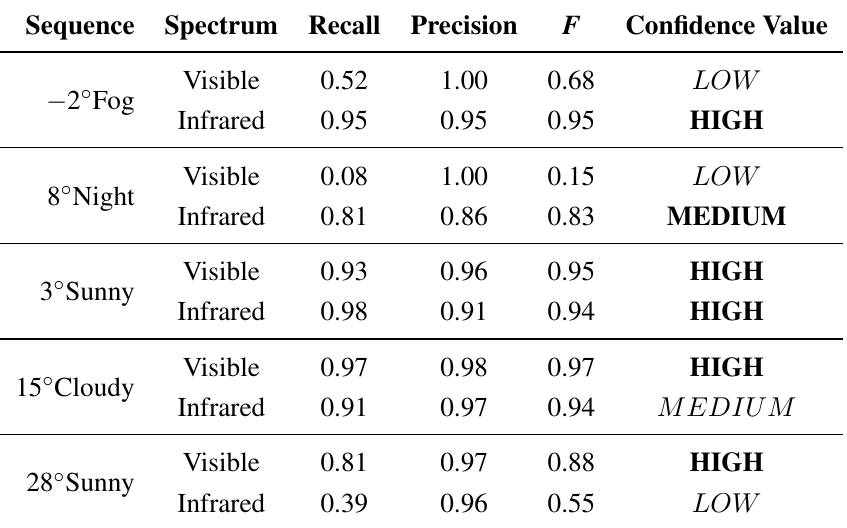
Table 4. Final results achieved for each sequence in both